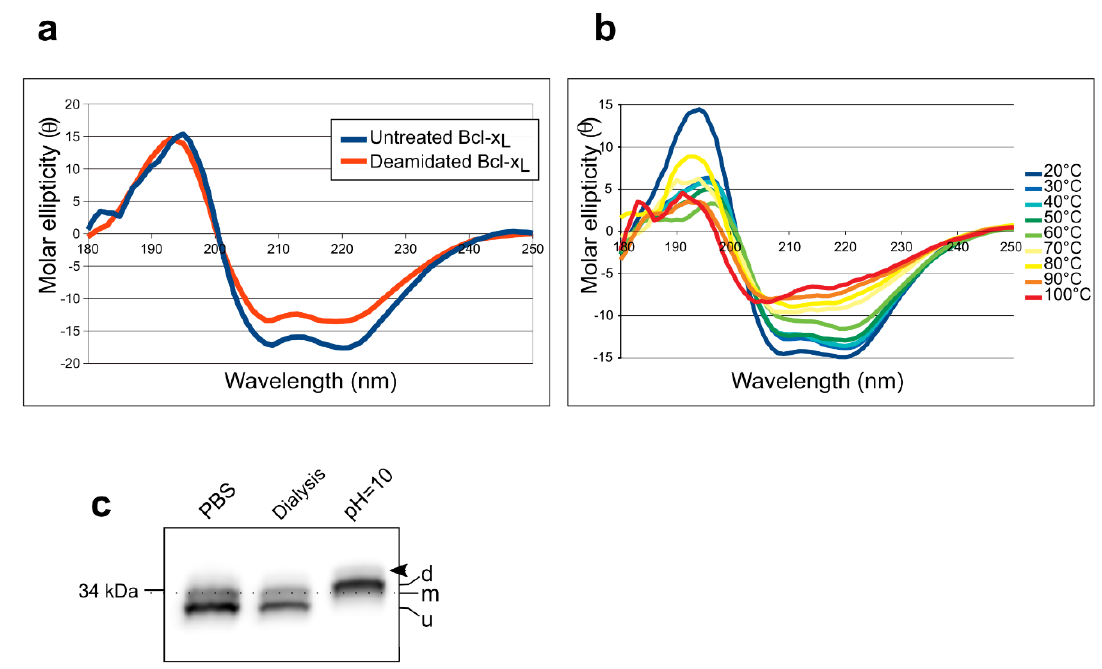
Figure 2. Folding and electrophoretic separation of chemically-induced deamidated Bcl-x L : ( a ) Storage buffer for purified His10-Bcl-x L (PBS) was replaced by dialysis with 10 mM phosphate (pH = 7.4) to accommodate circular dichroism requirements, and spectra were recorded between 180 and 250 nm on the untreated protein, or after alkaline treatment to accelerate deamidation. ( b ) Thermic denaturation of His10-Bcl-x L in 10 mM phosphate (pH = 7.4). ( c ) Immunodetection of Bcl-x L after separation on taurine – glycine gels of 25 µg of purified His10-Bcl-x L stored in PBS, or after dialysis against 10 mM phosphate, and after alkaline treatment. U: unmodified, m: monodeamidated, d: doubly-deamidated. Note that the linker between His10 and Bcl-x L contains an asparagine residue that introduces an additional deamidation site outside of Bcl-x L (arrow head).